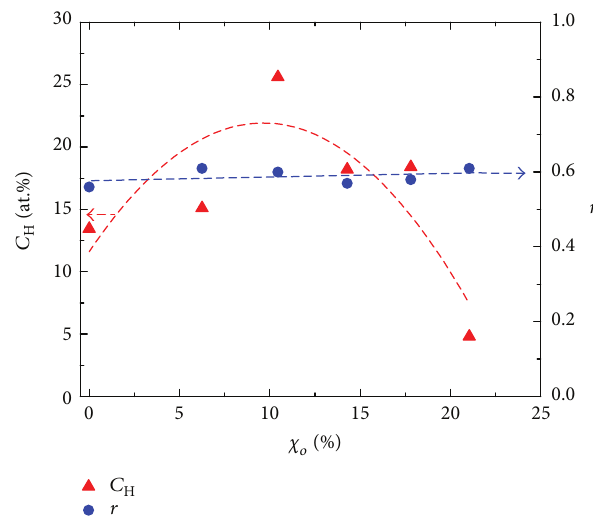
Figure 5: 𝐶 and 𝑟 as functions of 𝜒 𝑜 . 𝐶 H 10% CO 2 partial pressure, while 𝑟 is insensitive to 𝜒 𝑜 variation. The lines are guides for the